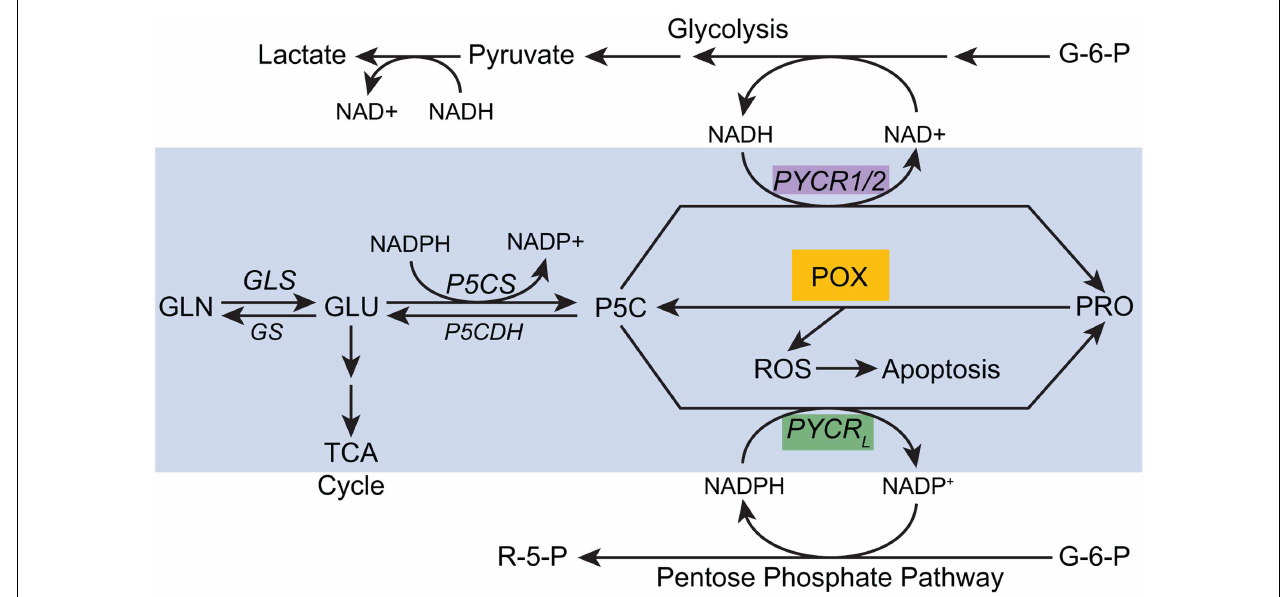
FIGURE 5 |A proposed model for parametabolic redox regulation by the proline regulatory axis. The model is a composite of functions which depend on temporo-spatial context; various activities may not occur simultaneously. For example, MYC inhibits POX but concomitantly activates P5CS and PYCR1 (see text).The enzymes shown are as follows: GLS, glutaminase; GS,